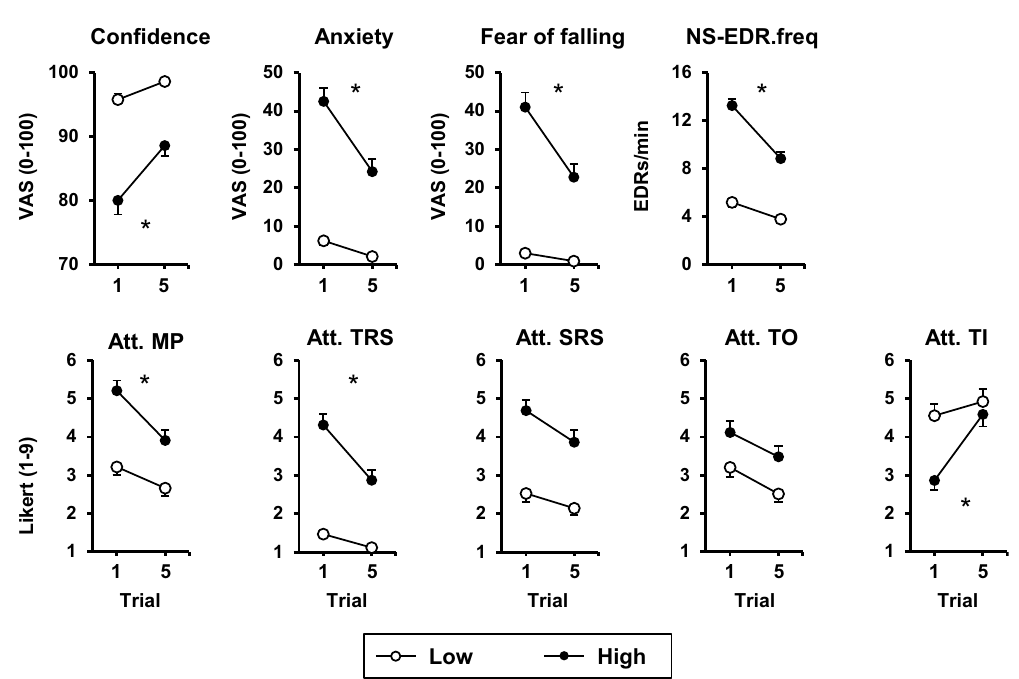
Figure 2. Effect of trial and threat across emotional and cognitive state measures. Group means and standard errors for the first and fifth trials across LOW and HIGH threat conditions are shown. NS-EDR.freq = non- specific electrodermal response frequency; Att. = attention toward; MP = movement processes; TRS = threat- related stimuli; SRS = self-regulatory strategies; TO = task objectives; TI = task irrelevant information. Asterisks indicate significant threat × trial